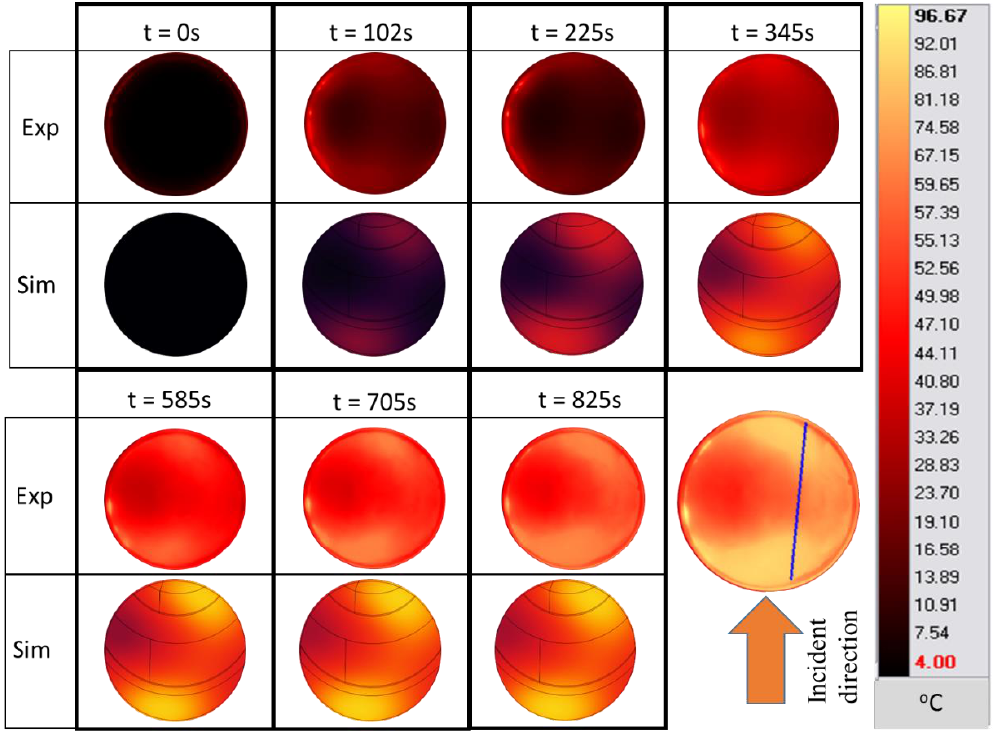
Figure 13. Surface temperature cartography of pâté during the ramp-up heating period at position A (simulation with hc 2 value). (The blue line is the temperature sampling line used in Figure 14).